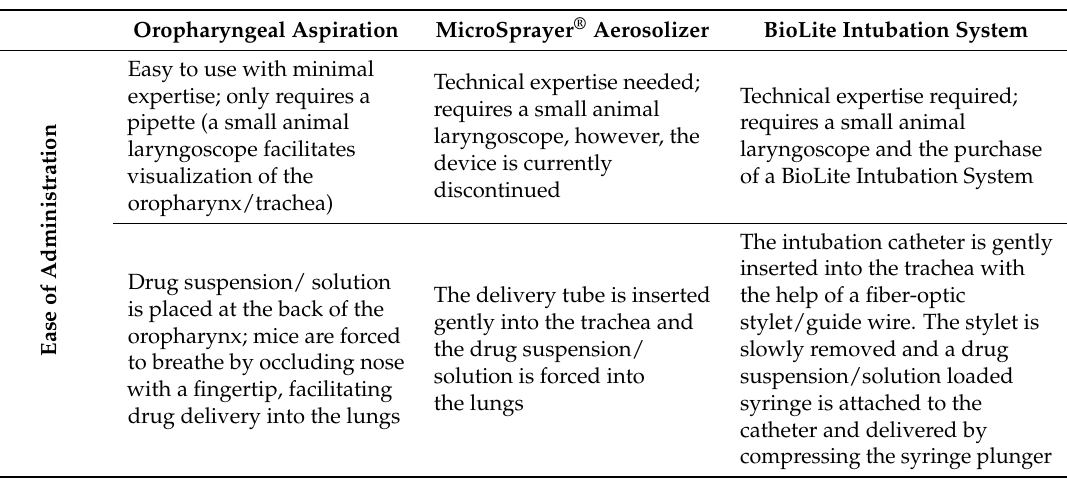
Table 1. Similarities and differences between oropharyngeal aspiration, the MicroSprayer ® Aerosolizer, and the BioLite Intubation